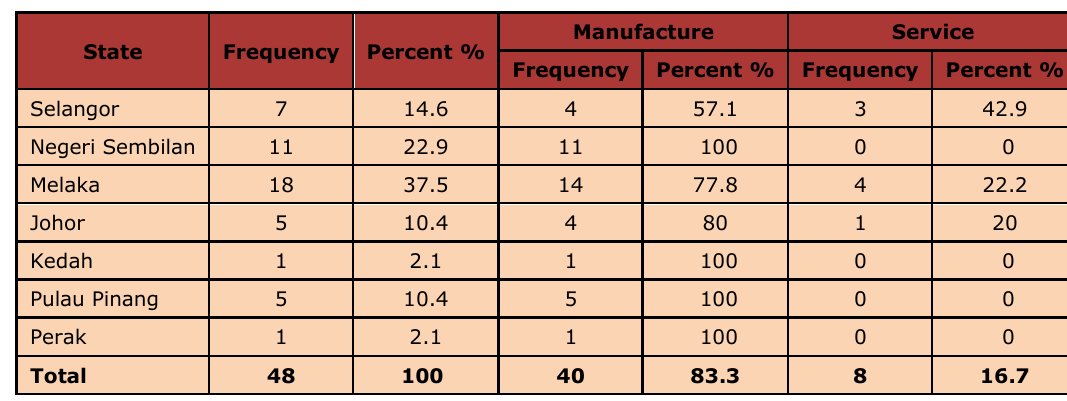
Table 1. Distribution of respondent based on State and